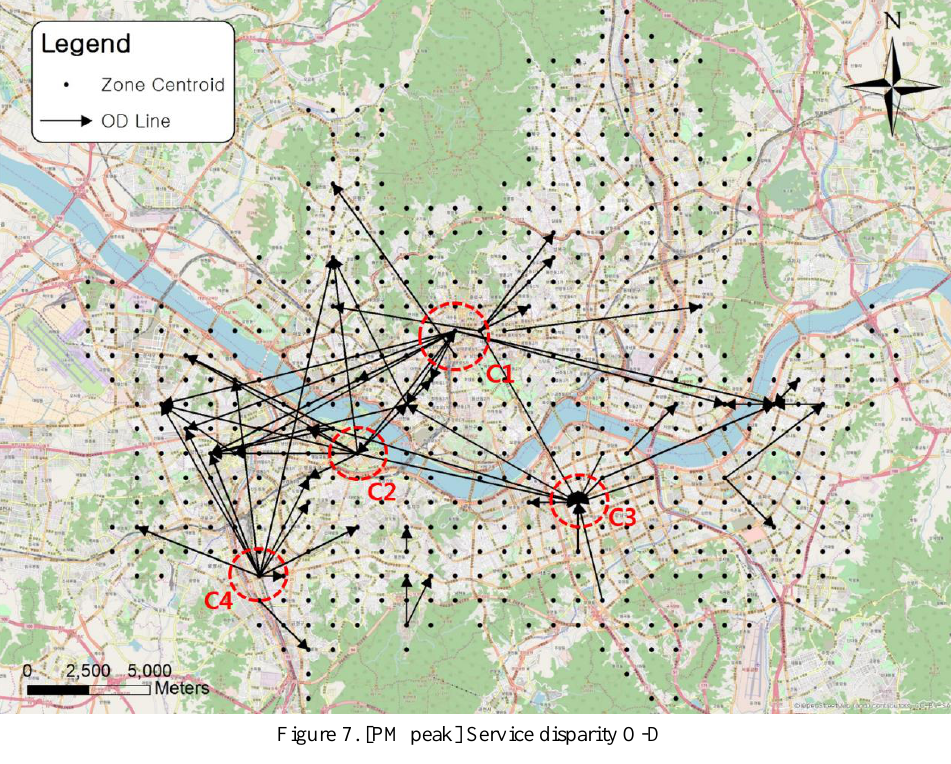
Figure 7. [PM peak] Service disparity O-D